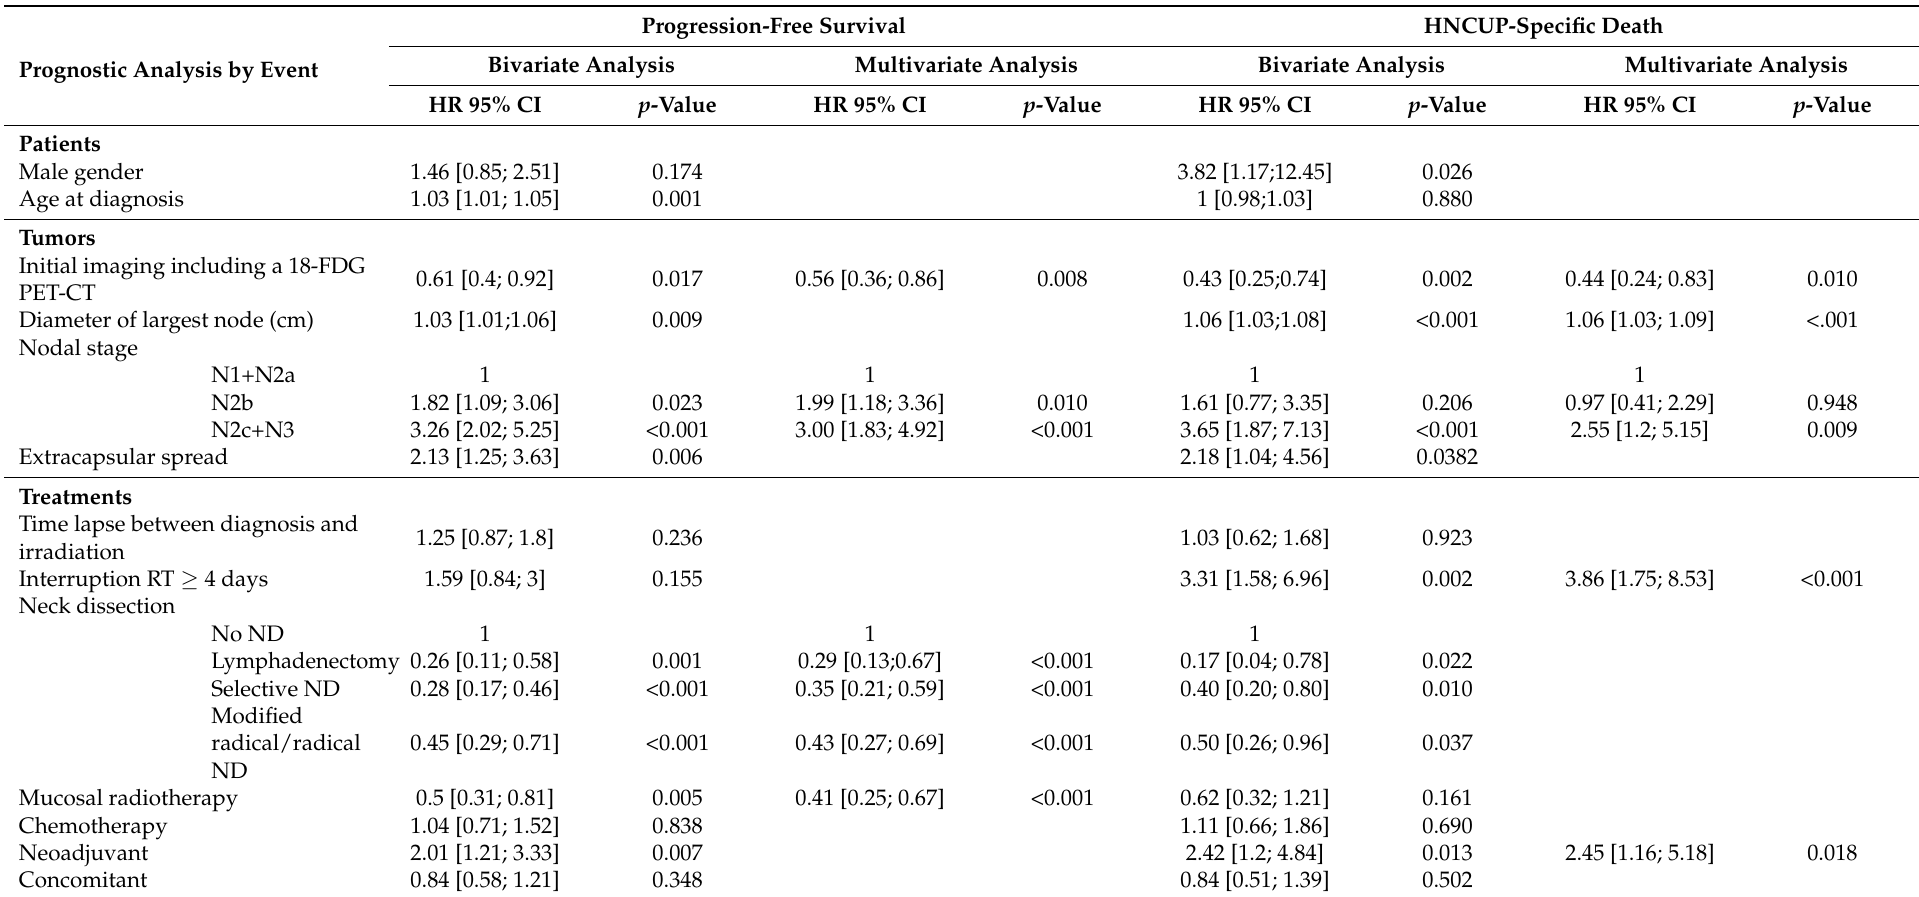
Table 3. Prognostic factors of progression-free survival and HNCUP-specific death in bivariate and multivariate analysis, using the Fine and Gray model for competitive factors.